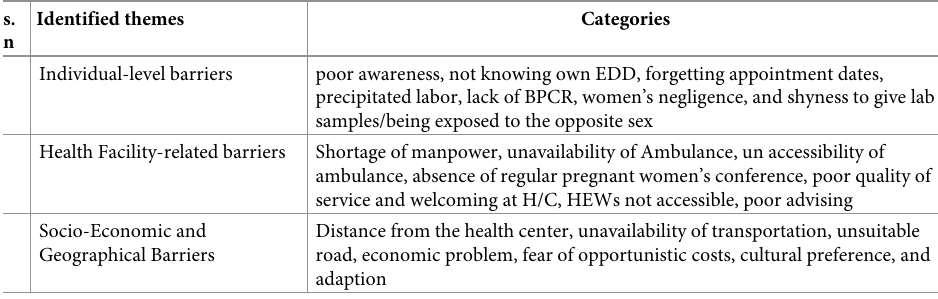
Table 1. Identified themes on barriers to maternal health service utilization, Dano, Midakegn, and Ilfata Districts, West Shoa Zone, Oromia, 2021. s. Identified n